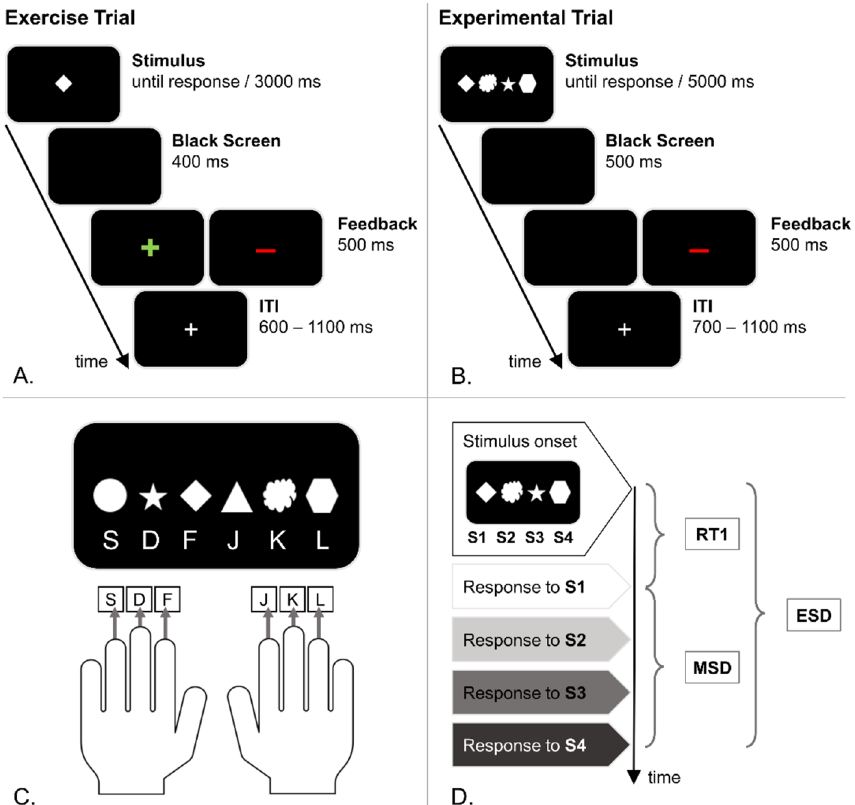
Figure 8. Outline of the newly developed habit paradigm. ( A ) Illustration of the time course of an exemplary single trial in milliseconds (ms) during the exercise. Feedback was given in each trial (green plus sign after correct responses; red minus sign in case of a wrong or missed response). The inter-trial interval (ITI) was jittered. ( B ) Illustration of the time course of a single trial in milliseconds (ms) during the experiment. Negative feedback (red minus) was given in case of a wrong or missed response. No feedback (i.e., a black screen) was displayed in case all four responses were correct. The inter-trial interval (ITI) was jittered. ( C ) Overview of task-relevant stimulus–response (S-R) associations, which were established during the exercise. ( D ) Overview of the obtained response time measures. The first motor response (RT1) defines the time passed between stimulus onset and the first response. The motor sequence duration (MSD) is defined as the time passed between first and last response. The entire sequence duration (ESD) is defined as the time passed between stimulus onset and the last